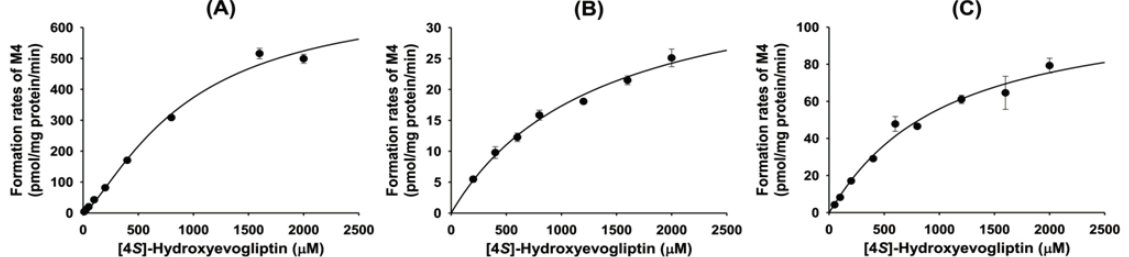
Figure 6. Enzyme kinetics for the metabolism of 4( S )-hydroxyevogliptin (M2) to 4( S )-hydroxyevogliptin glucuronide (M4) in ( A ) pooled human liver microsomes; ( B ) human cDNA-expressed UGT2B4; and ( C ) human cDNA-expressed